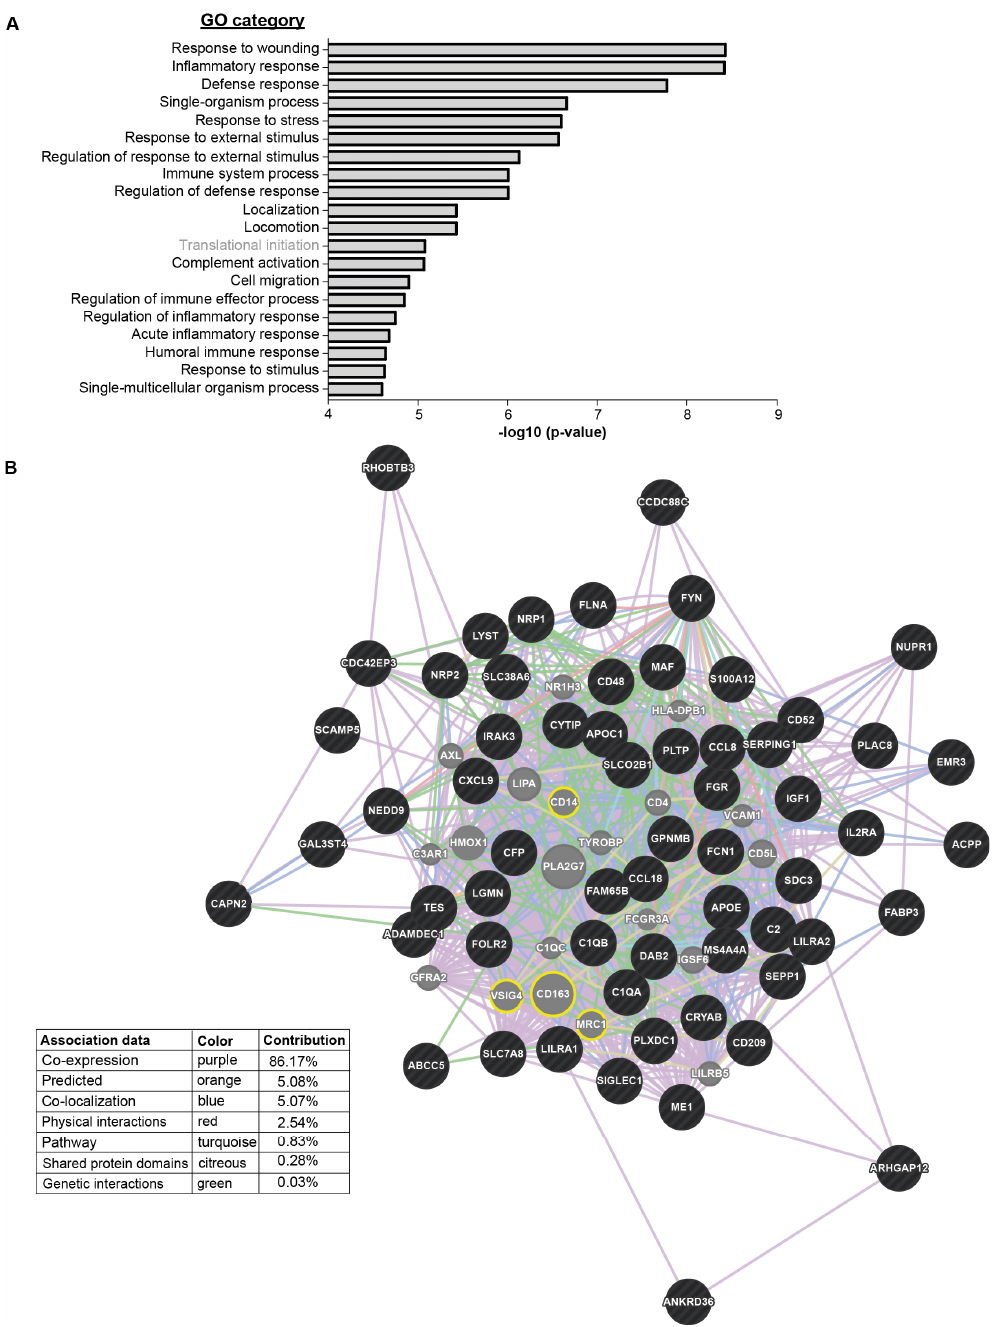
Figure 5. GO categories and functional network of ercDC_ccRCC. ( A ) Upregulated DEGs were enriched in 19 of the top 20 categories. Downregulated DEGs were only enriched in one category (“Translational initiation”) of the top 20 significantly enriched terms. Significance of GO category enrichment is depicted as − log10 ( p -value). ( B ) Functional associations of ercDC_ccRCC marker genes (black) and their computed related genes (grey) by GeneMANIA network analysis. Yellow circles highlight related genes mentioned in the text. Associations were defined based on different criteria (colored lines, see Table).